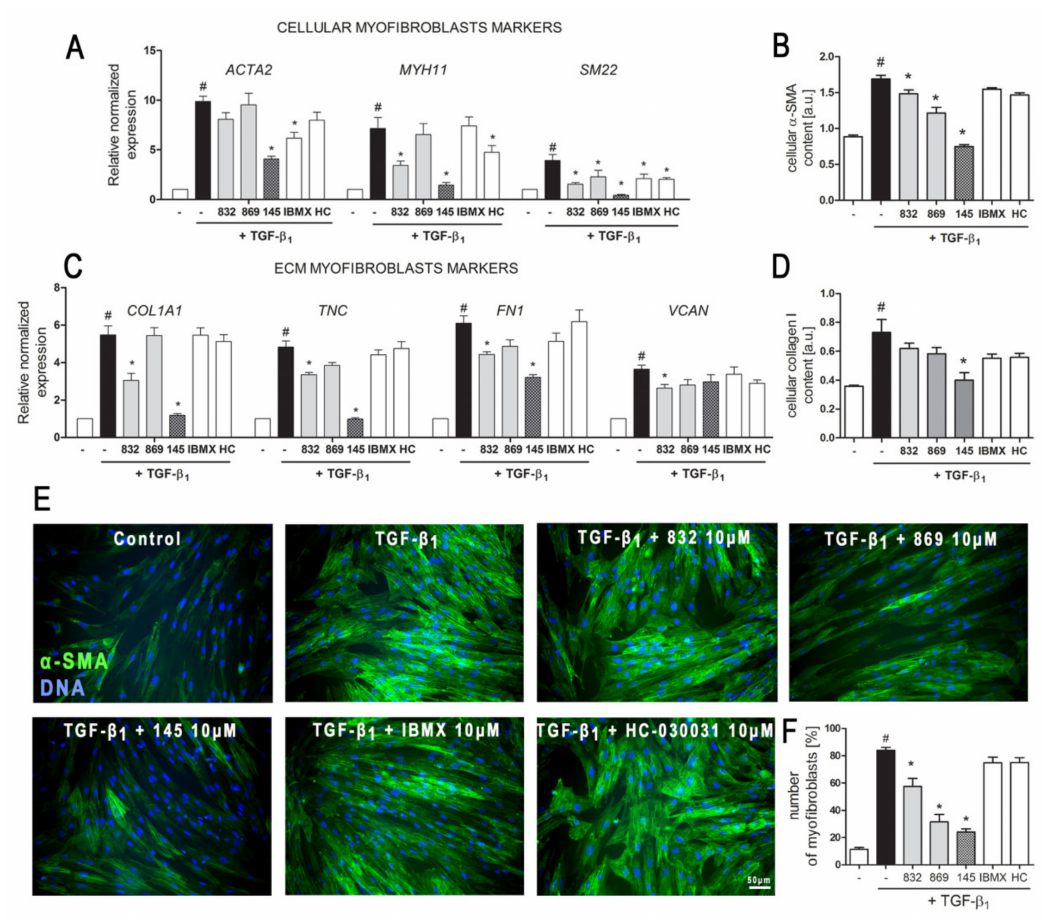
Figure 3. Compound 145 significantly reduced TGF- β 1 -induced MRC-5 transition into myofibroblasts. MRC-5 were pre-incubated for 1 h with the studied compounds (10 µ M) and then cultured for 24 h ( A , C ) or 48 h ( B , D – F ) in TGF- β 1 (5 ng / mL). ( A , C ) qPCR was carried out to analyze ACTA2, MYH11, SM22, COL1A1, TNC, FN1 , and VCAN transcript levels. Samples were run three times in